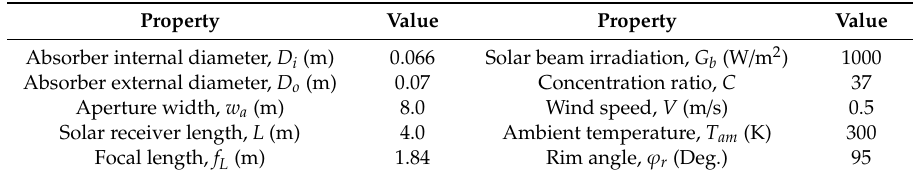
Table 1. The PTC model parameters used in the current